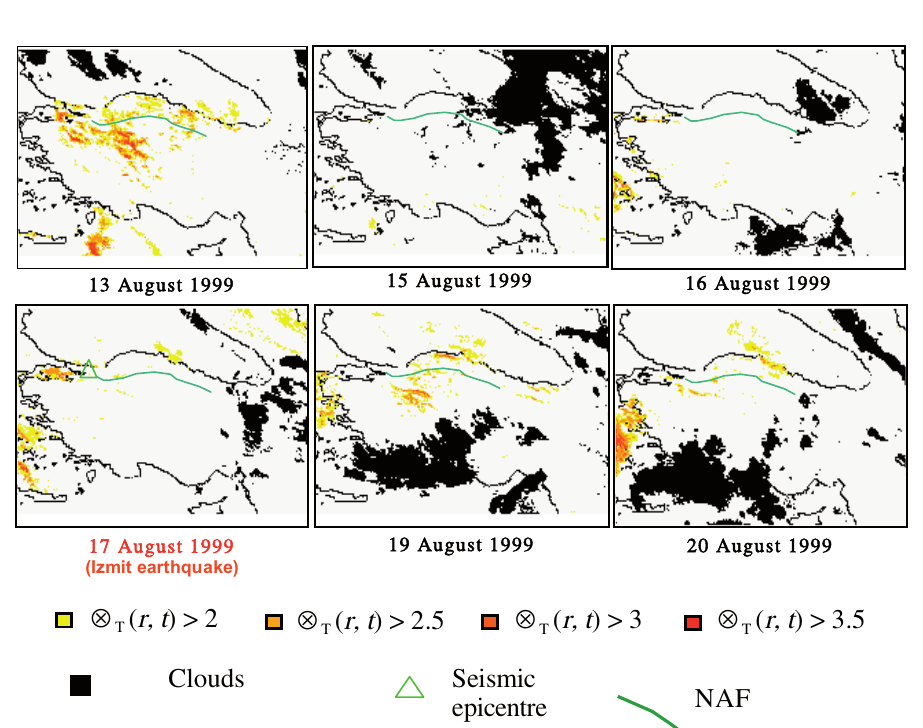
Fig. 5. The RST approach applied to geostationary satellite data (Meteosat). Results of the analysis of the dai- ly ⊗ ∆ T ( r,t ) index computation on the epicentral area of the day of Izmit’s earthquake. The unperturbed signal be- haviour, in terms of µ ∆ T ( r ) and σ ∆ T ( r ), was determined on the basis of eight years of satellite records collected in similar observational conditions (adapted from Tramutoli et al. ,